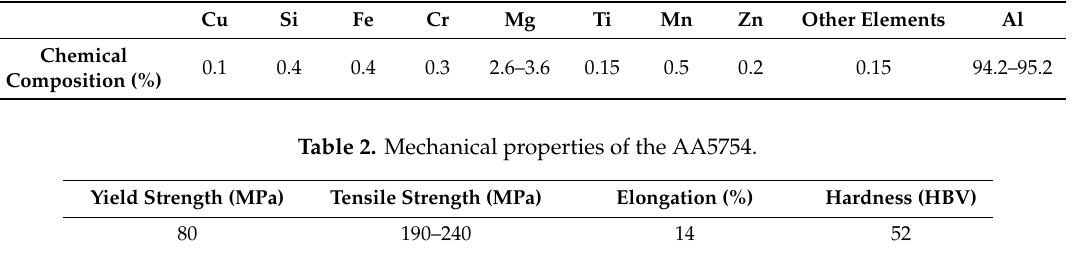
Table 1. Chemical composition of the AA5754.